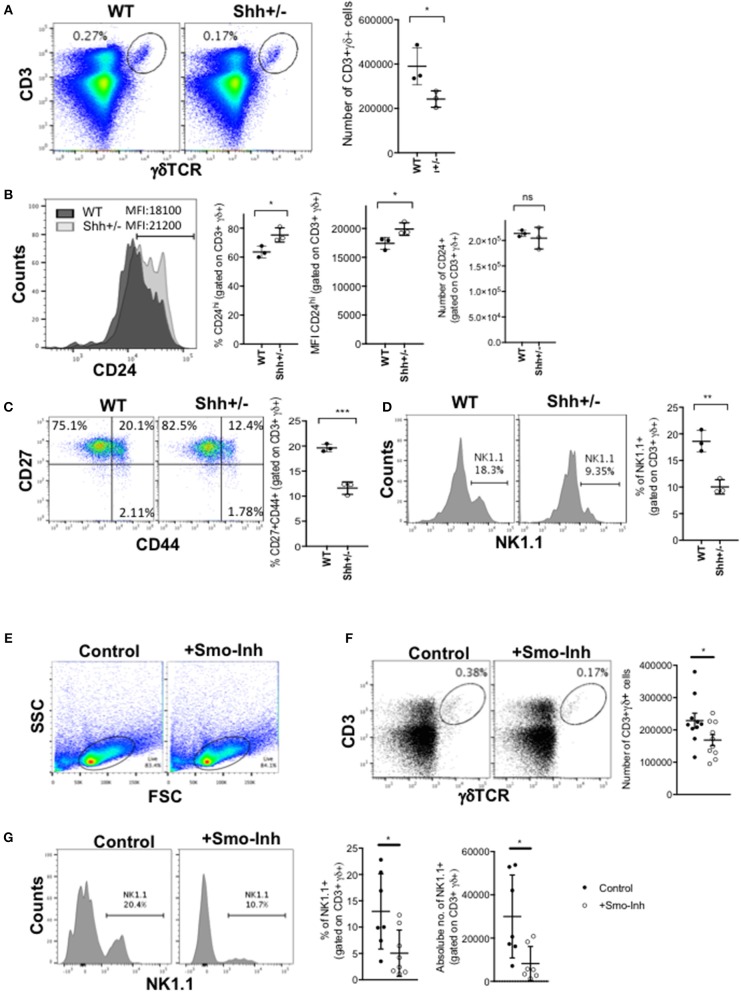
Shh and Smo promote γδ cell differentiation and influences γδ subset distribution in adult thymus. (A–D) Flow cytometry of adult Shh+/+ (WT, n = 3) and Shh+/- (n = 3) littermate thymus. (A) Dot plot shows anti-CD3 against anti-γδ staining from representative WT and Shh+/- littermate thymus, giving the percentage of cells in the region shown. Scatter plot shows the number of CD3+γδ+ cells recovered. (B) Representative histogram overlays show anti-CD24 staining, gated on CD3+γδ+ in WT (dark shade) and Shh+/- (light shade) adult thymus, giving the MFI. Left-hand scatter plot shows the percentage of CD24hi cells (that fall within the marker shown on the histogram). Middle scatter plot shows MFI of anti-CD24 staining gated on CD3+γδ+ cells. Right-hand scatter plot shows the number of CD24+CD3+γδ+ cells in WT and Shh+/- littermate thymus. (C) Representative dot plot shows CD27 and CD44 expression, gated on CD3+γδ+ cells, giving the percentage of cells in the quadrants. The scatter plot shows the percentage of CD27+CD44+ cells, gating on CD3+γδ+ cells. (D) Representative histogram shows NK1.1 expression, gated on CD3+γδ+ cells, giving the percentage of cells in the marker. The scatter plot shows the percentage of NK1.1+ cells, gating on CD3+γδ+ cells. (E–G) Adult WT mice were injected ip with 40 μg/day of the Smo-inhibitor (Smo-Inh) PF-04449913 (Pfizer) (n = 10) or vehicle control (DMSO) (n = 10) daily for 14 days and thymus analyzed by flow cytometry. (E) Representative dot plot shows FSC vs. SSC to show the live gate used. (F) Representative dot plot shows CD3 and γδ expression in control and Smo-Inh-treated thymus. Scatter plot shows number of CD3+γδ+ cells recovered per thymus from control and Smo-Inh-treated mice. (G) Representative histogram shows NK1.1 expression, gated on CD3+γδ+ cells from control and Smo-Inh-treated thymus. Scatter plots show the percentage (left) and number (right) of NK1.1+ cells, gated on CD3+γδ+ cells, per thymus from control and Smo-Inh-treated mice. In all scatter plots in this figure, each point represents an individual mouse and bars show mean ± SEM. *p < 0.05; **p < 0.01; ***p < 0.005.